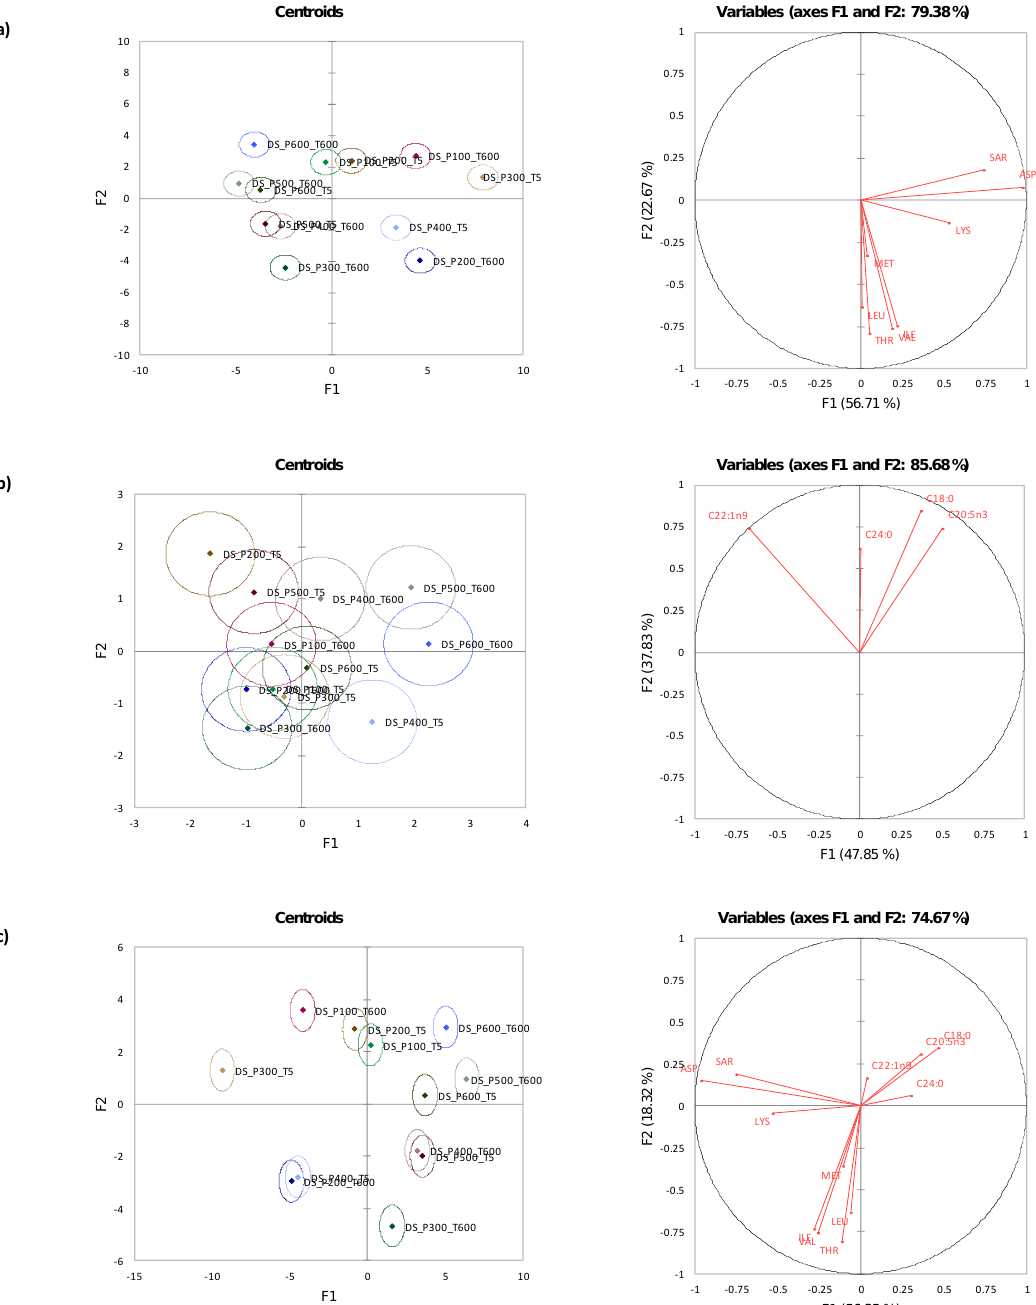
Figure 2. Canonical variate analysis centroids (left) and vectors (right) for ( a ) free amino acid (F (88,410) = 19.917, p < 0.001), ( b ) fatty acids (F (44,222) = 4.385, p < 0.001), and ( c ) both free amino acids and fatty acids (F (132,233) = 16.230, p < 0.001) of Diamond Shell ( Spisula aequilatera ) clam.